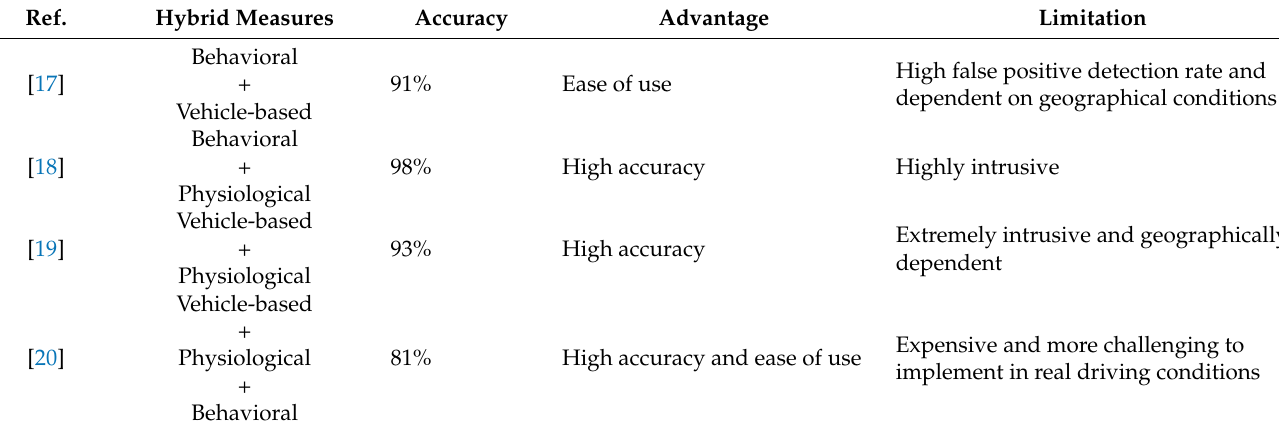
Table 1. Possibility of combination of various